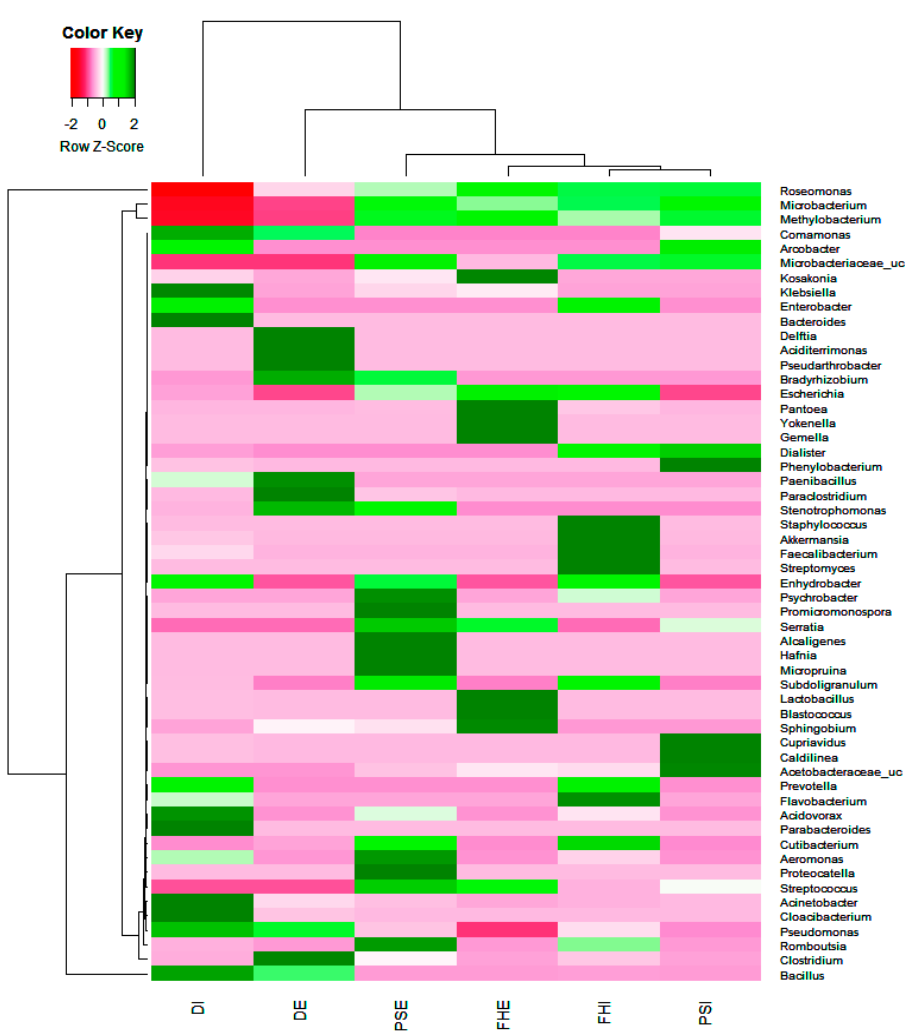
Figure 3. Heat map showing top 20 genera in the influent and effluent samples. The 20 dominant genera in each sample were selected and compared with their abundances (percentages) in other samples. The color intensity (log scale) in each panel shows the percentage of a genus in a sample, referring to a key.